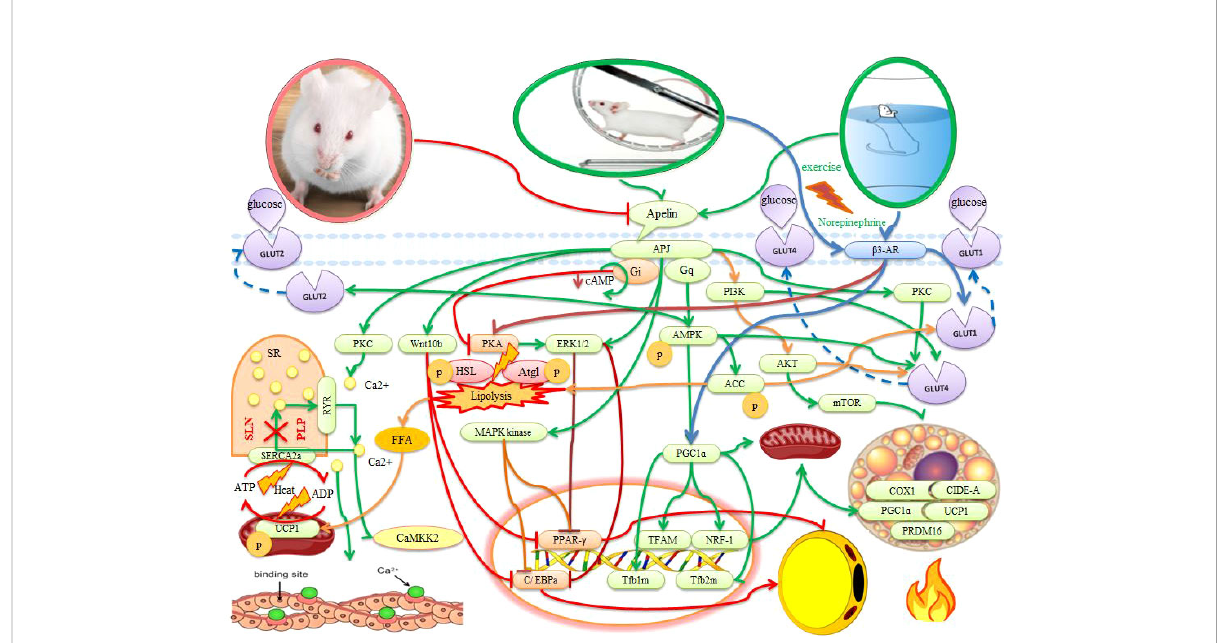
FIGURE 1 The effects of apelin and exercise on adipose tissue, muscle, and placenta in animals. The description is available in the text. Abbreviations are given at the beginning of the